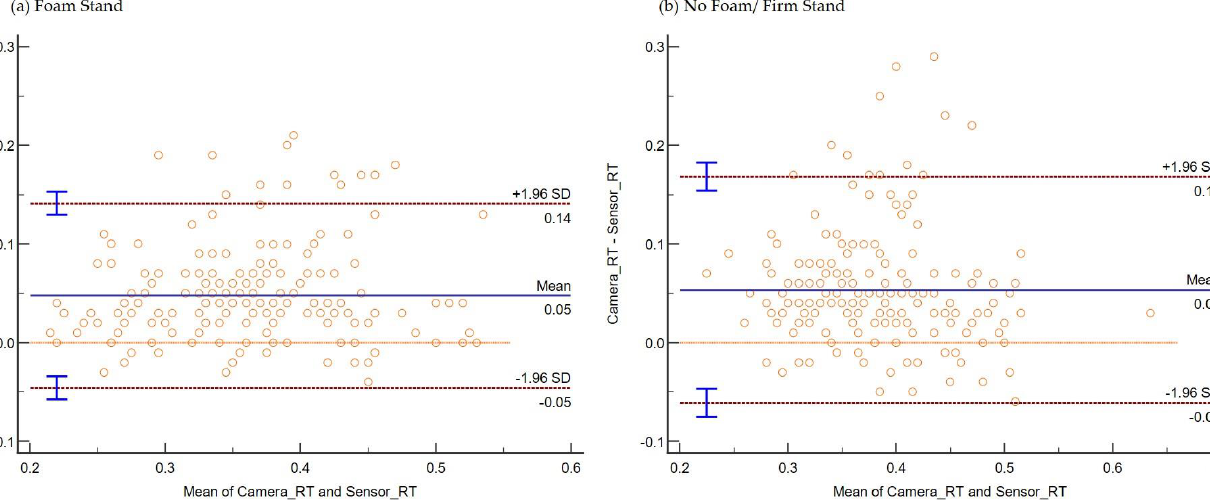
measurements during ( a ) foam surface standing and ( b ) firm surface standing. The camera system